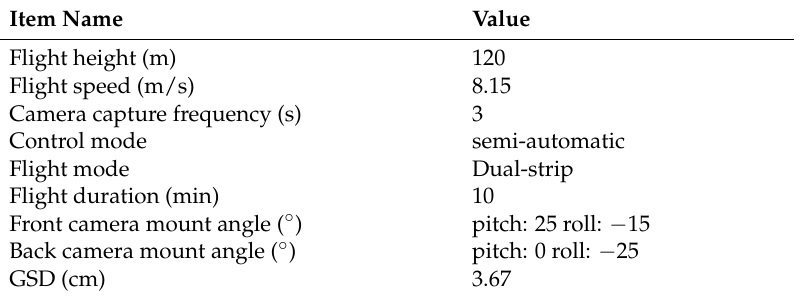
Table 3. Configuration of UAV photogrammetric